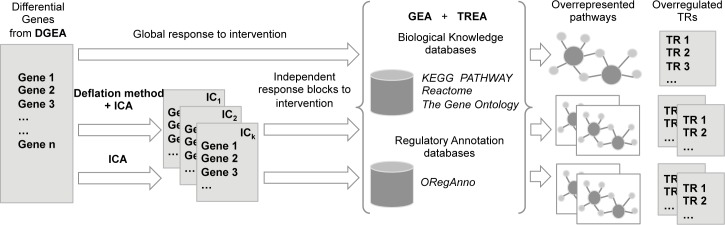
Complete workflow implemented for the study.The differential genes list obtained from the differential gene expression analysis is taken as the initial step for the workflow. This represents the global response to intervention but can also be decomposed in independent components through an Independent Component Analysis (ICA) to obtain the independent block response. ICA is computed after applying a deflation method to the original expression data. Gene and transcriptional regulator (TR) enrichment analyses are computed over the global and independent response. Results are summarized in overrepresented pathway graphs and overrepresented TRs rankings.